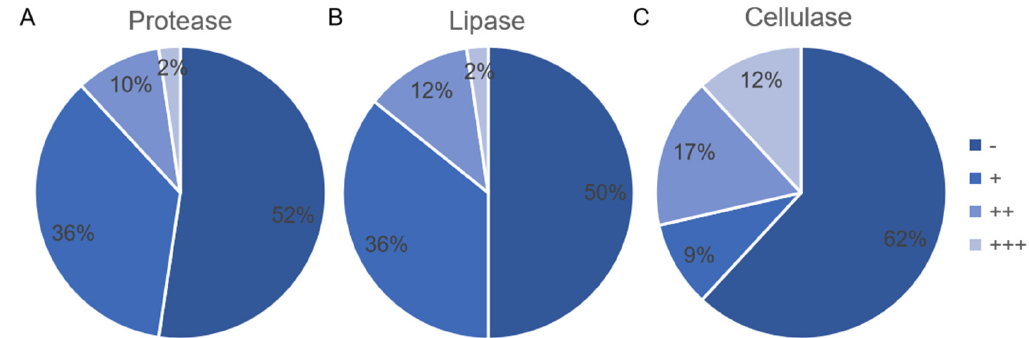
Figure 5. Screening results of the portion of endophytic bacterial isolates producing protease ( A ), lipase ( B ), and cellulose ( C ) (Notes:-: negative (E = 1), +: weak (1 < E ≤ 2), ++: moderate (2 < E ≤ 3), +++: strong (E > 3)).